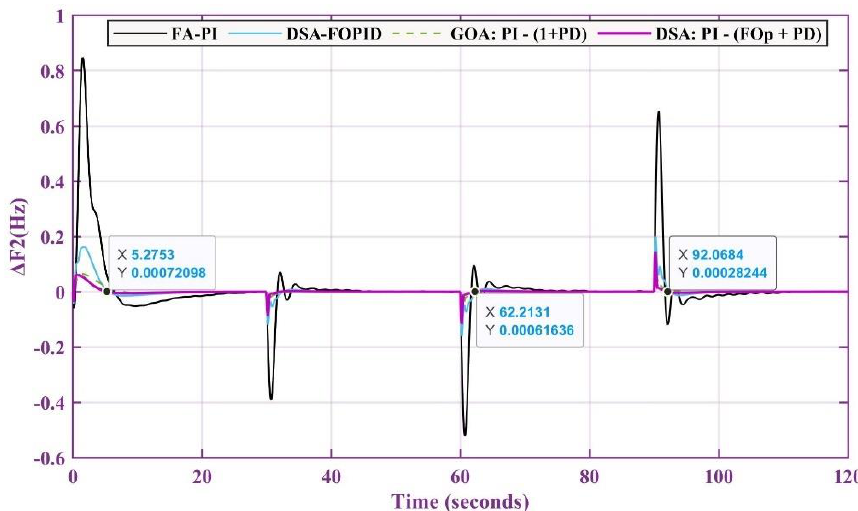
Figure 16. Area-1 response with communication delay.